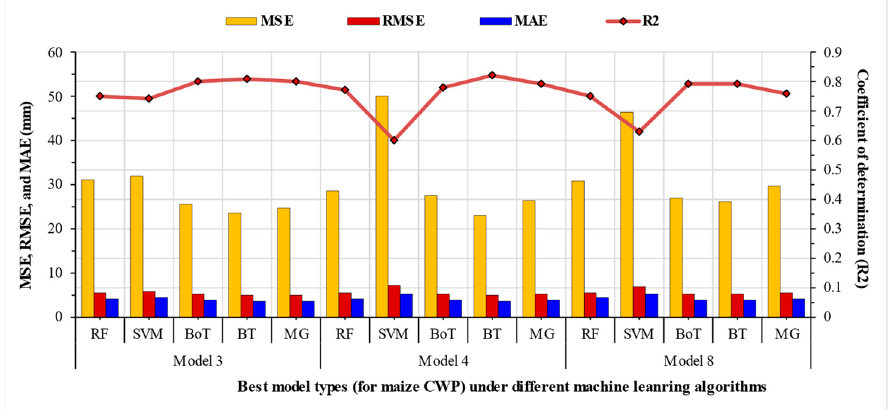
Highlighted models indicate the best performance of the machine learning algorithm considering R 2 , MSE, RMSE, and MAE.